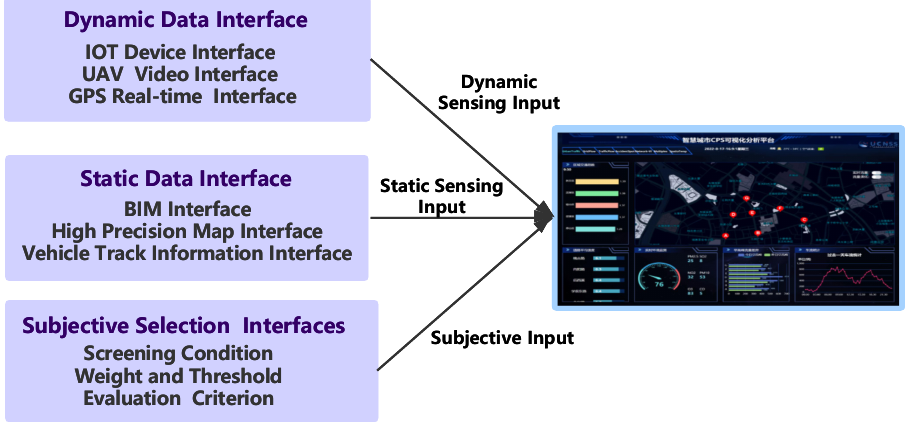
Figure 4. Data input interface. The dynamic data interface is mainly for dynamic interactive data in the data layer described in Figure 2, while the static data interface is for static modelling data; the subjective selection data interface is an interface for designers to process data according to the subjective conditions (such as threshold, filter conditions, etc.) required by practical